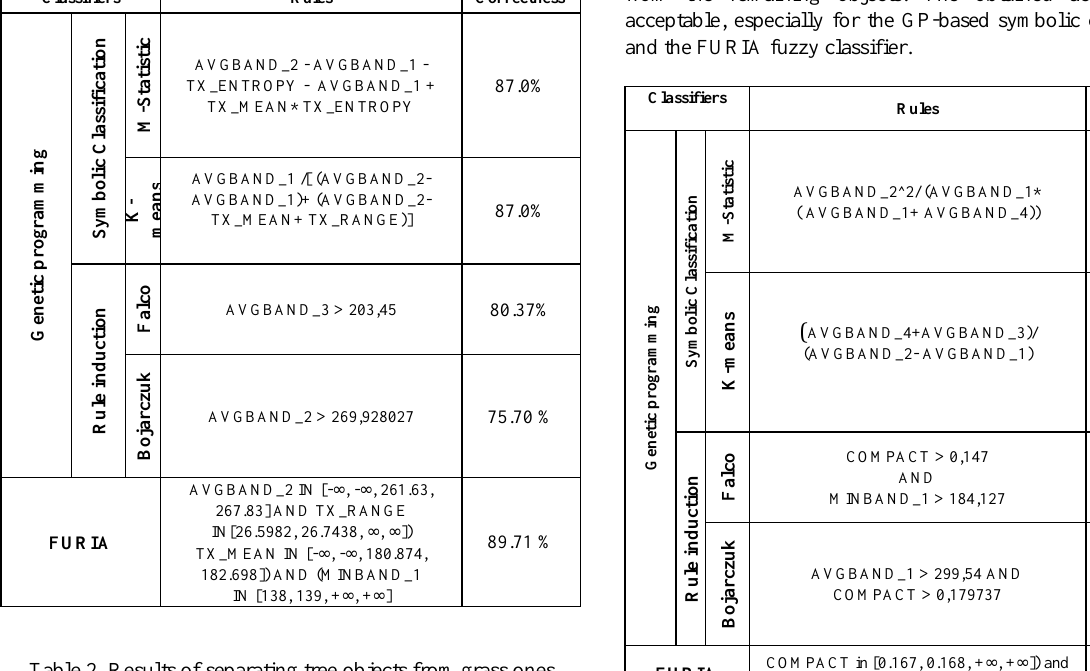
Table 2. Results of separating tree objects from grass ones From the table 2. We can conclude that almost algorithms have added new attributes to the rules; among them are texture parameters and